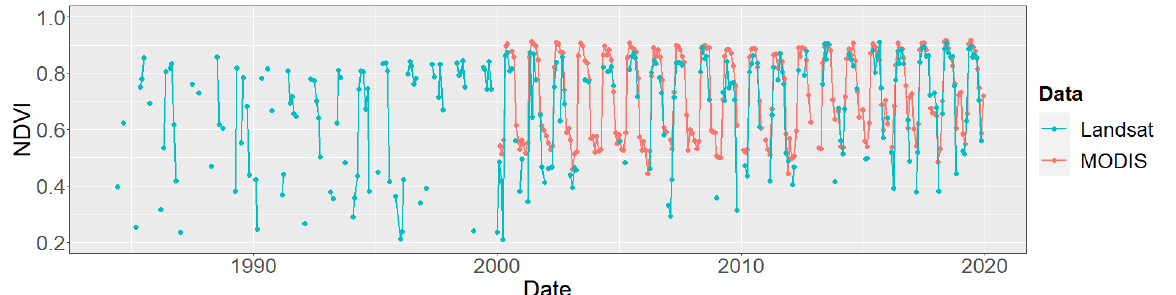
Figure 11. Monthly median NDVI values for Landsat and MODIS data of the Steigerwald. Remote sensing imagery was masked from clouds, cloud shadows and snow. Adjacent months with available data are connected with a line. MODIS data has a smaller temporal coverage compared to Landsat data, but provides less noisy values. Furthermore, MODIS features a higher data continuity than